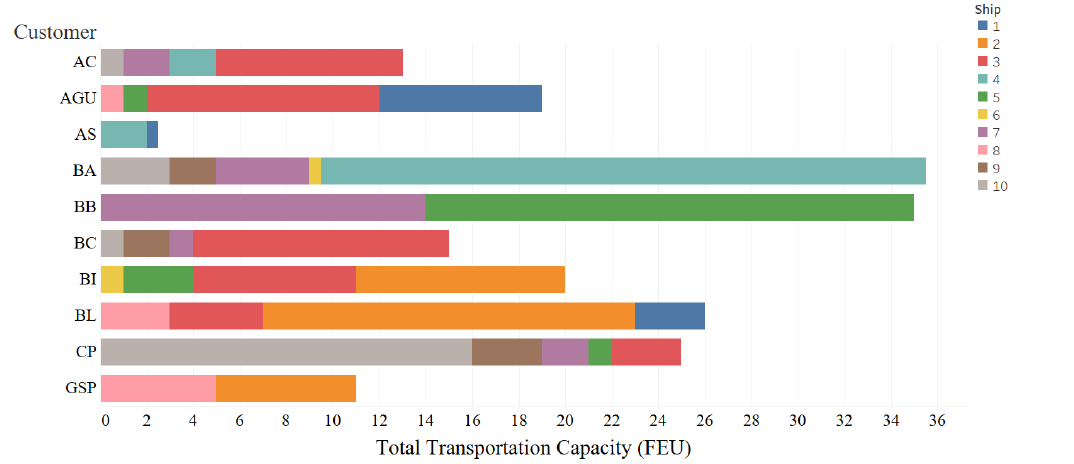
Figure 4. Result of deterministic